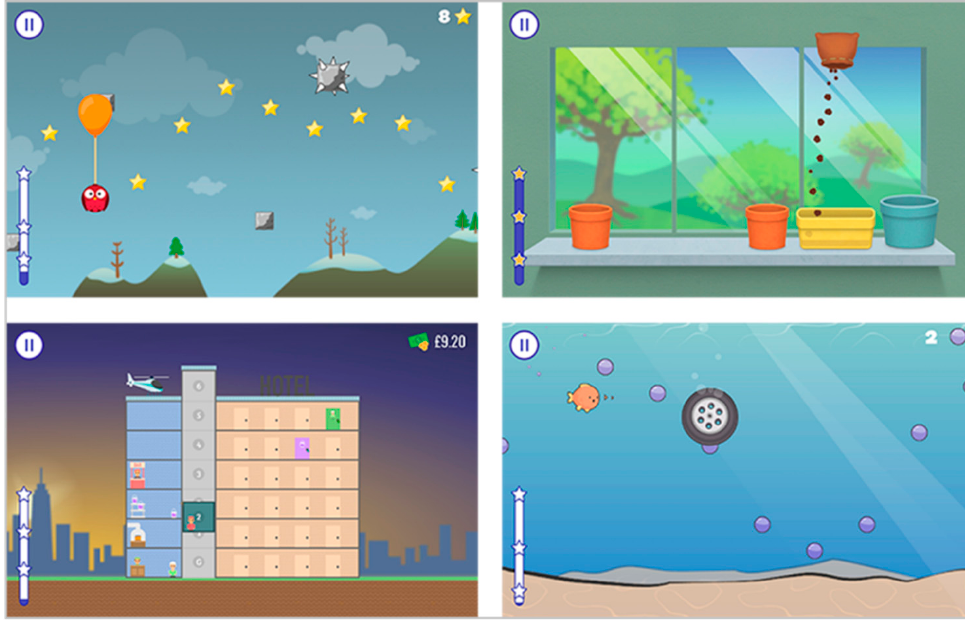
Figure 2. Games from the GripAble software that were used in the present study. ( Top left ): Balloon Buddies; ( top right ): Windowsill; ( bottom left ): Concierge; and ( bottom right ): Pufferfish. The second device that was used is the Smart Sensor Egg ; it is a novel device created for hand training (see Figure 3).